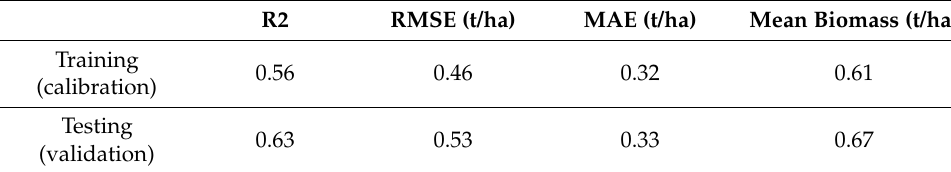
Table 3. Model performance during the training and testing